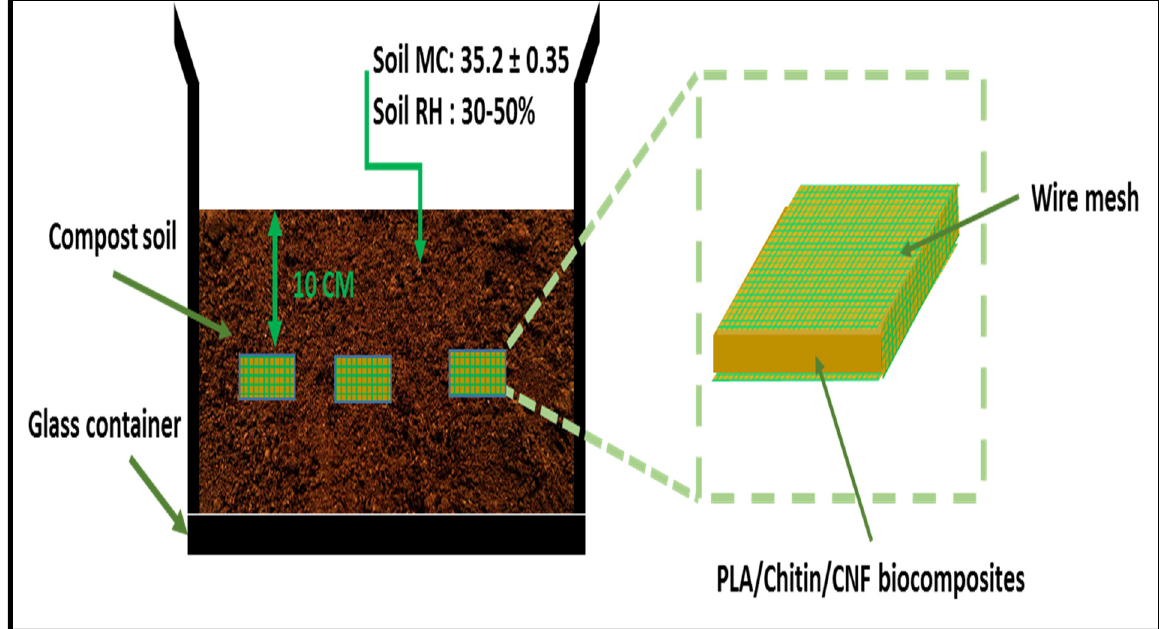
Figure 10. Schematic drawing of soil burial test set up for molecular biodegradation of neat PLA and